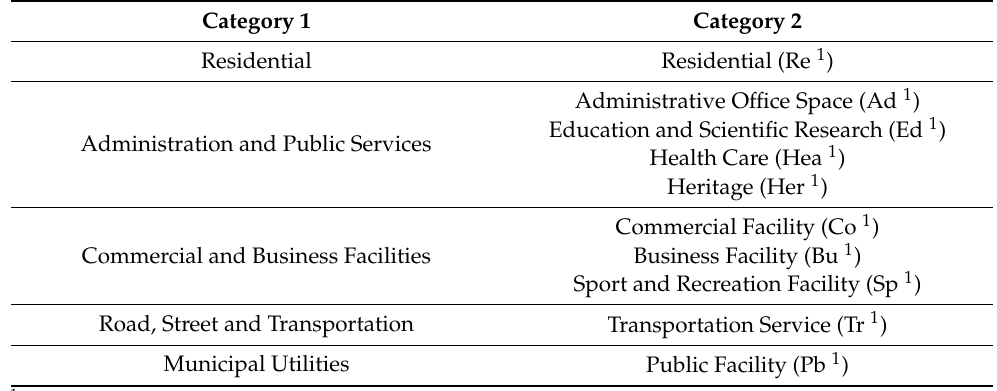
Table 2. The UFZ classification